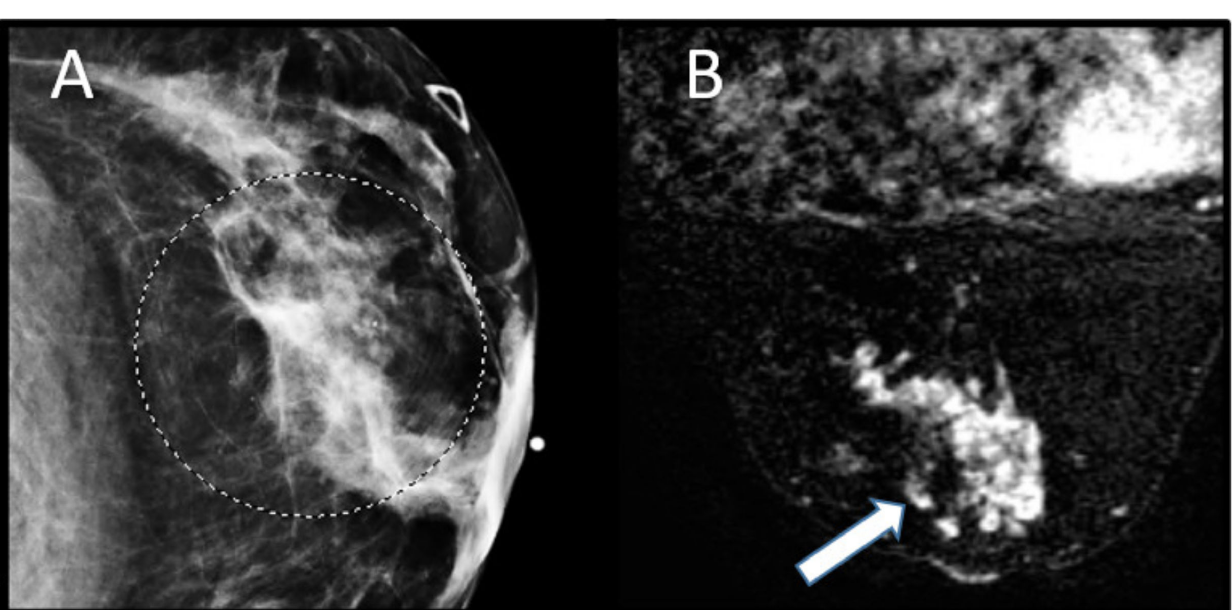
Figure 6. A 37-year-old woman with a clinical diagnosis of Cowden syndrome (negative for PTEN mutation) and history of thyroid cancer at age of 24 and Wilms tumor at age 5, presenting with a palpable left breast mass. ( A ) Mammographic examination demonstrates an irregular mass in the 3 o’clock position centered 1 cm from the nipple with microcalcifications (circle). ( B ) Postcontrast, fat-saturated magnetic resonance image of the breast shows mass enhancement involving 3 of 4 quadrants due to multiple confluent masses (arrow), which was pathologically found to represent invasive mammary carcinoma with predominantly lobular differentiation and focal ductal